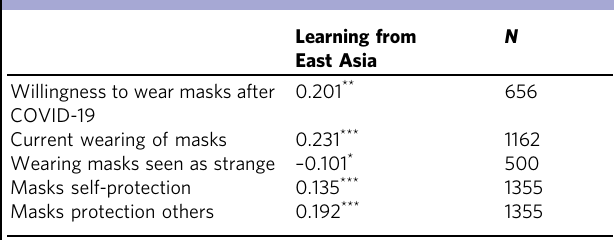
Table 3 Learning from East Asia correlates signi fi cantly with various attitudes towards masks, during and after the pandemic (Pearson